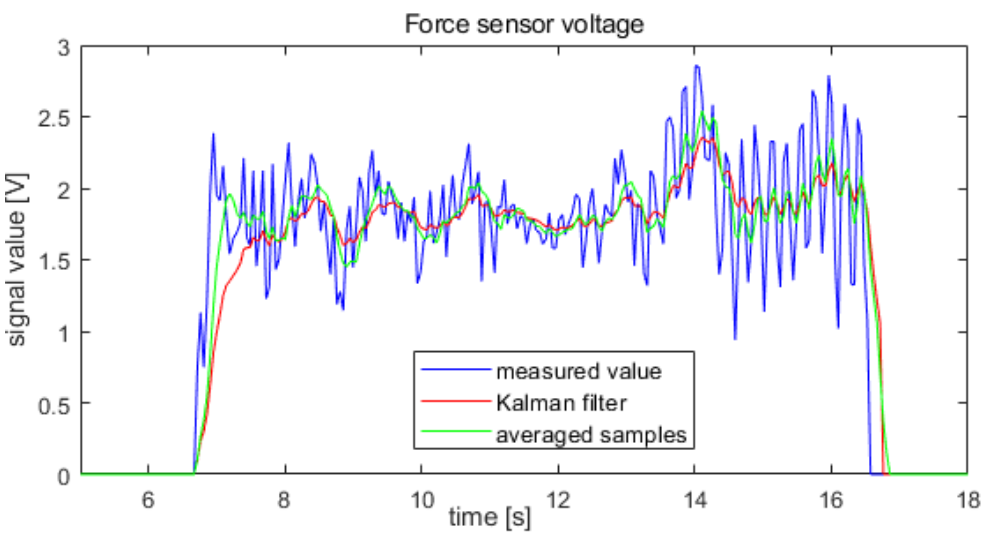
Figure 12. Signal waveforms from the force sensor during arm tremor: without filtration, after running averaging for 0.3 s, and after applying the Kalman filter.